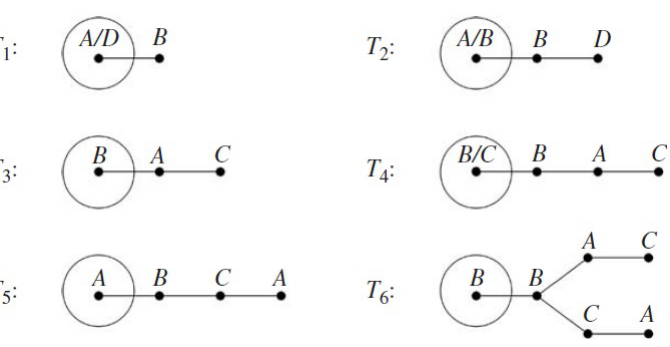
Figure 4. Vertex status of A, B, C and the six Operations